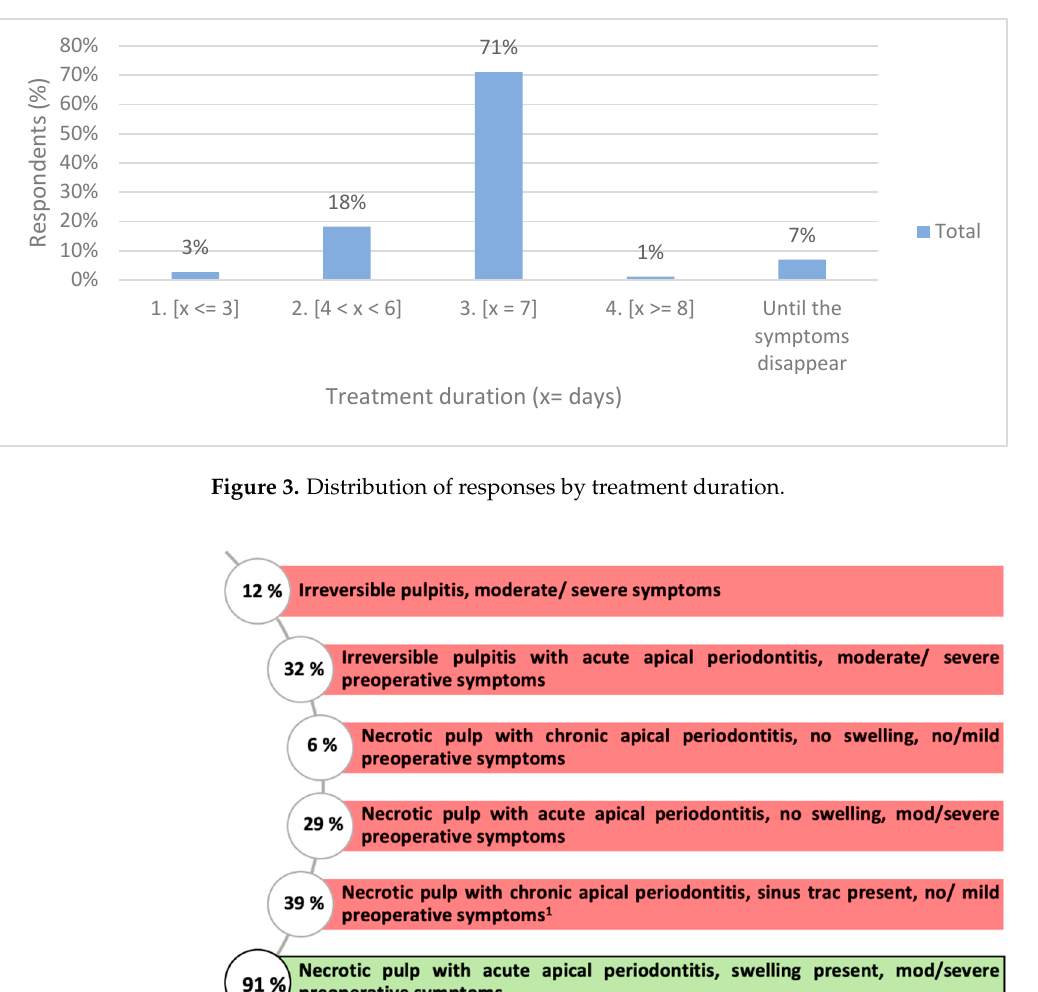
Figure 3. Distribution of responses by treatment duration.